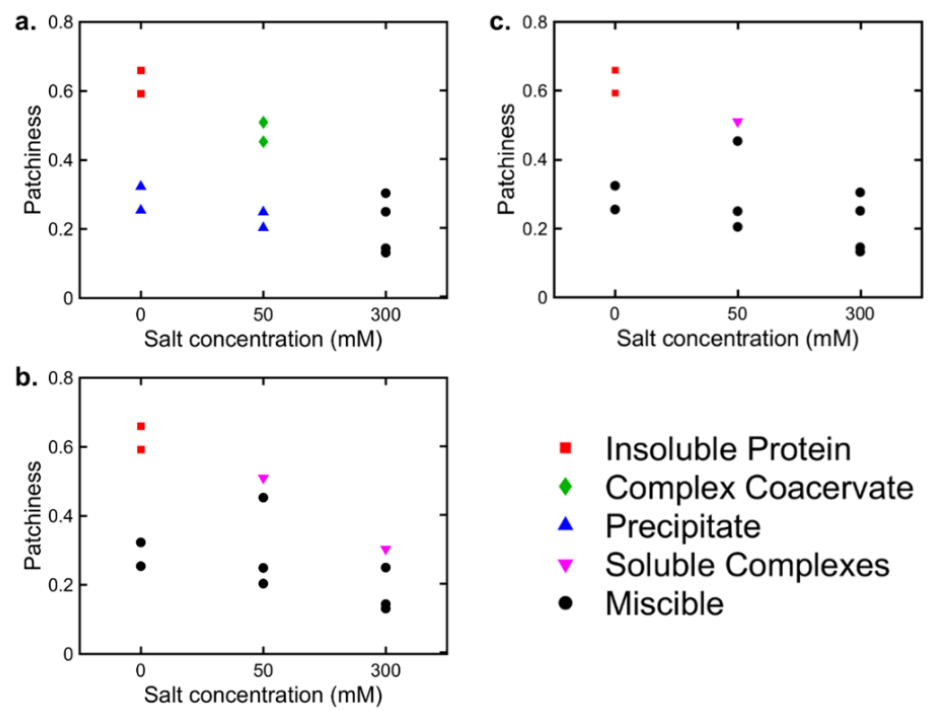
Figure 6. Phase diagram of GFP variants with ( a ) quaternized poly(4-vinylpyidine, ( b ) polyacrylic acid, and ( c ) hyaluronic acid at maximal complexation for different patchiness values. Reprinted with permission from [69]. Copyright 2020 American Chemical Society.